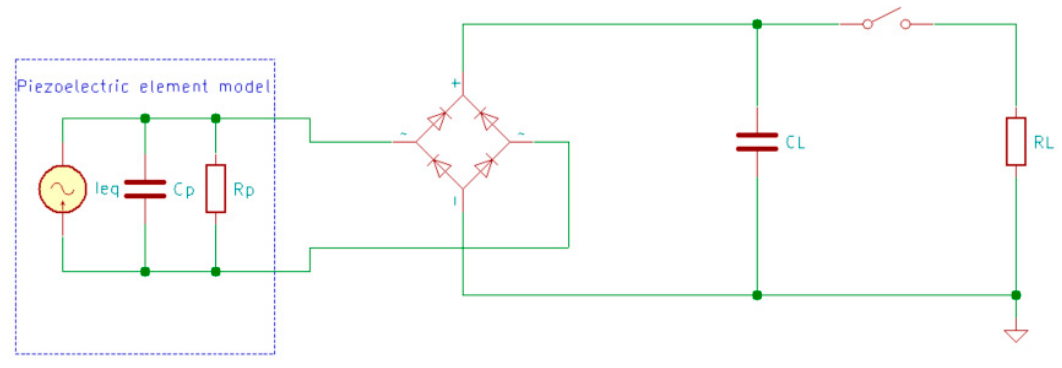
Figure 15. Standard AC-DC energy harvesting circuit with electric piezoelectric model.